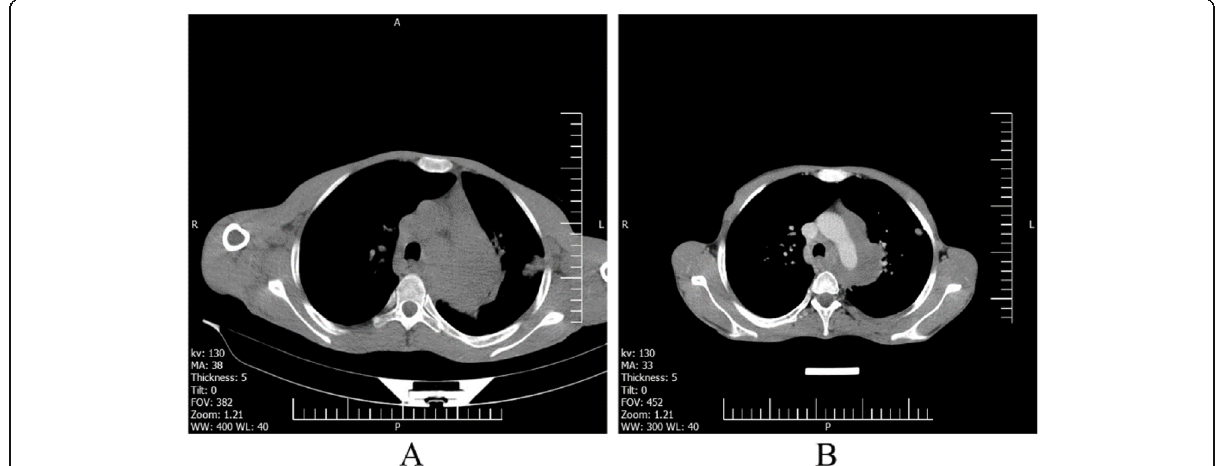
Fig. 2 CT scan of the lungs and mediastinum with and without contrast. a An enlarged mass exists in the mediastinum. b Venous phase of CT with contrast shows that the aortic arch is encased by a mass which is not